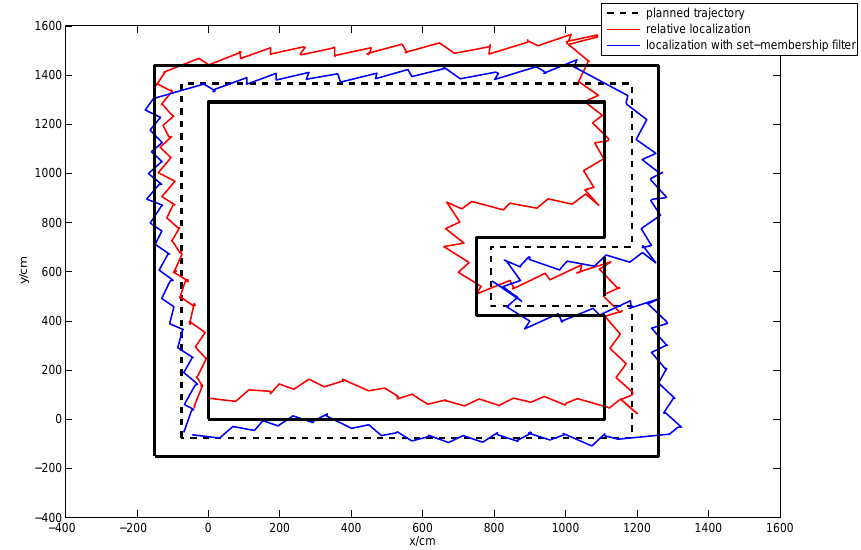
Figure 17. The average trajectory curves of subject A walking with normal steps.